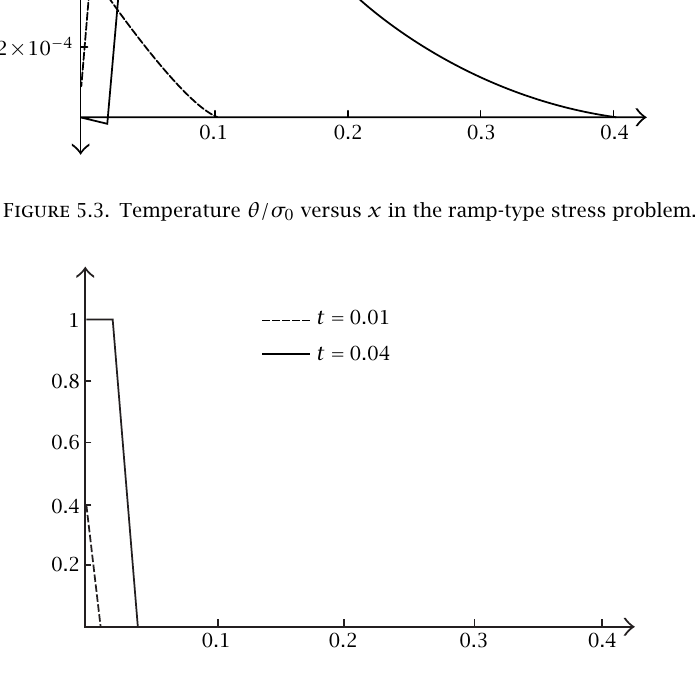
Figure 5.4 . Stress σ/σ 0 versus x in the ramp-type stress